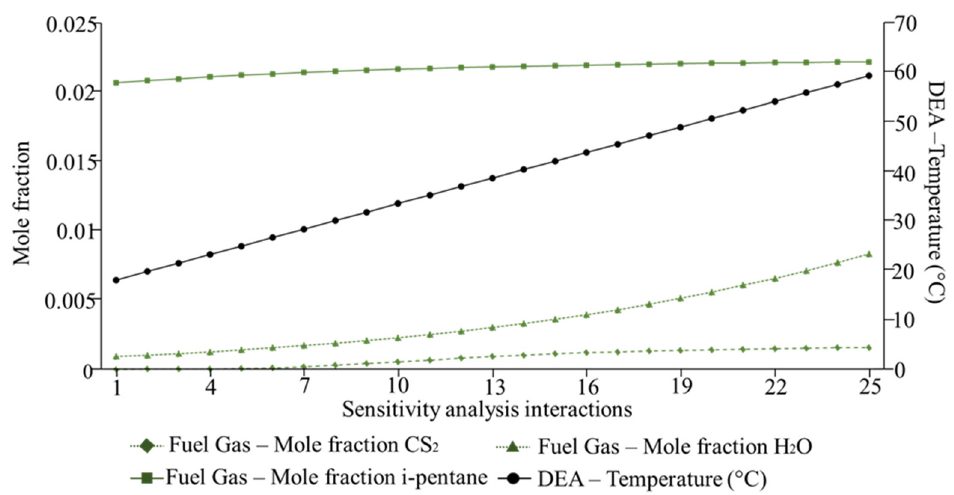
Figure 6. DEA temperature vs. i-pentane, H 2 O, and the CS 2 , mole fraction.